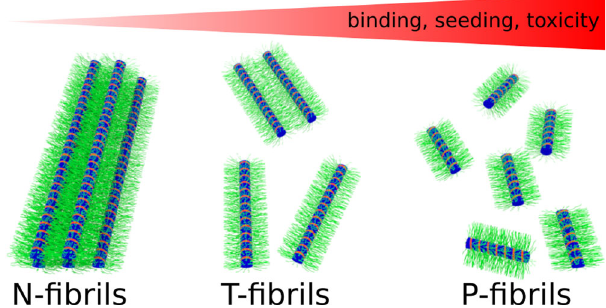
Fig. 8 Model of the N-, T-, and P- fi brils. The PRDs of the N- fi brils (green) are entangled resulting in bundling and consequently less accessible fi bril surfaces. The PRDs of the T- fi brils are keeping the individual fi brils more separate. The P- fi brils are shorter and their PRD are even less restricted and more